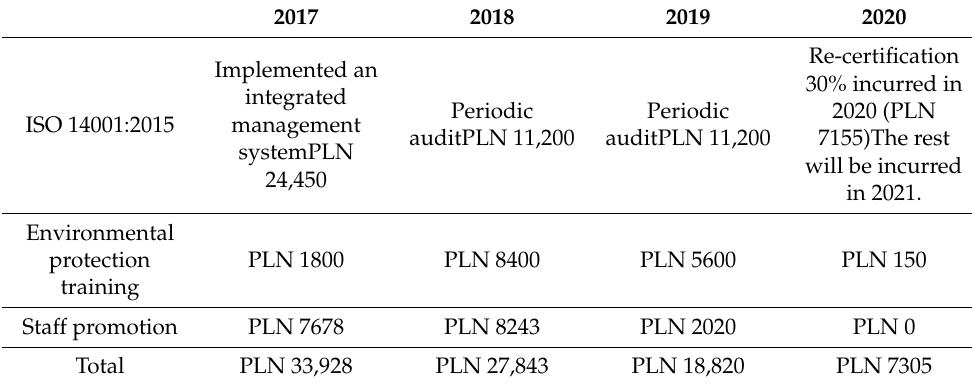
Table 3. List of ECSR activities of Miejska Energetyka Cieplna Sp. z o. o. in Koszalin, 2017–2020. Source: own